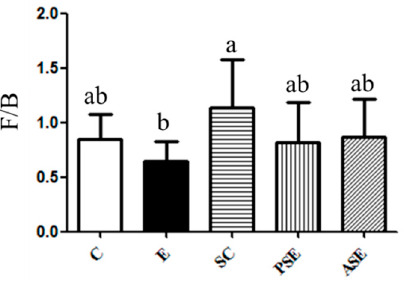
Figure 4. Effects of synbiotics on the Firmicutes-to-Bacteroidetes (F/B) ratio in rats with chronic ethanol feeding. Bars are the mean ± standard deviation ( n = 6). Different letters indicate a significant difference at p < 0.05 by a one-way ANOVA with Duncan’s post-hoc test.